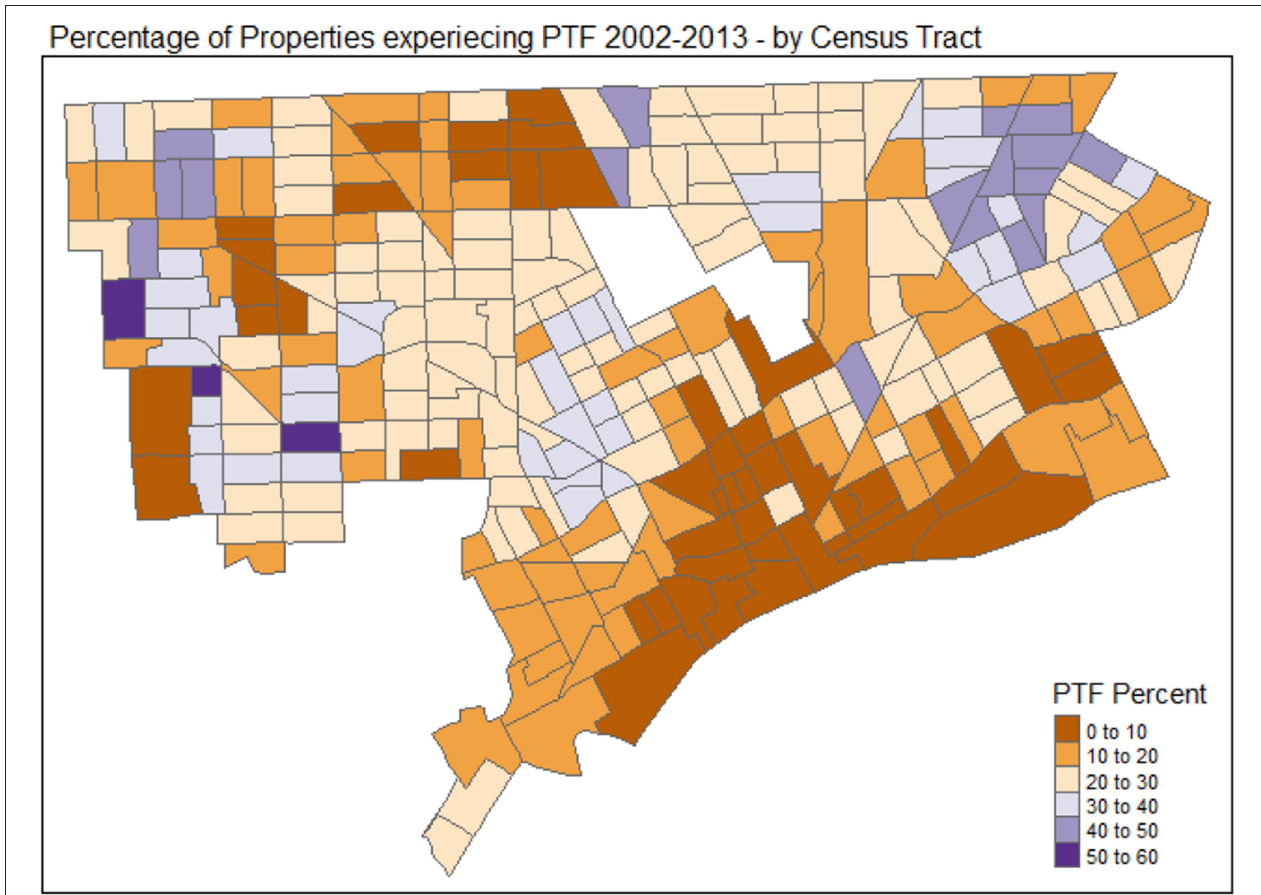
FIGURE 1 | Property tax foreclosure thematic map (Tennekes,